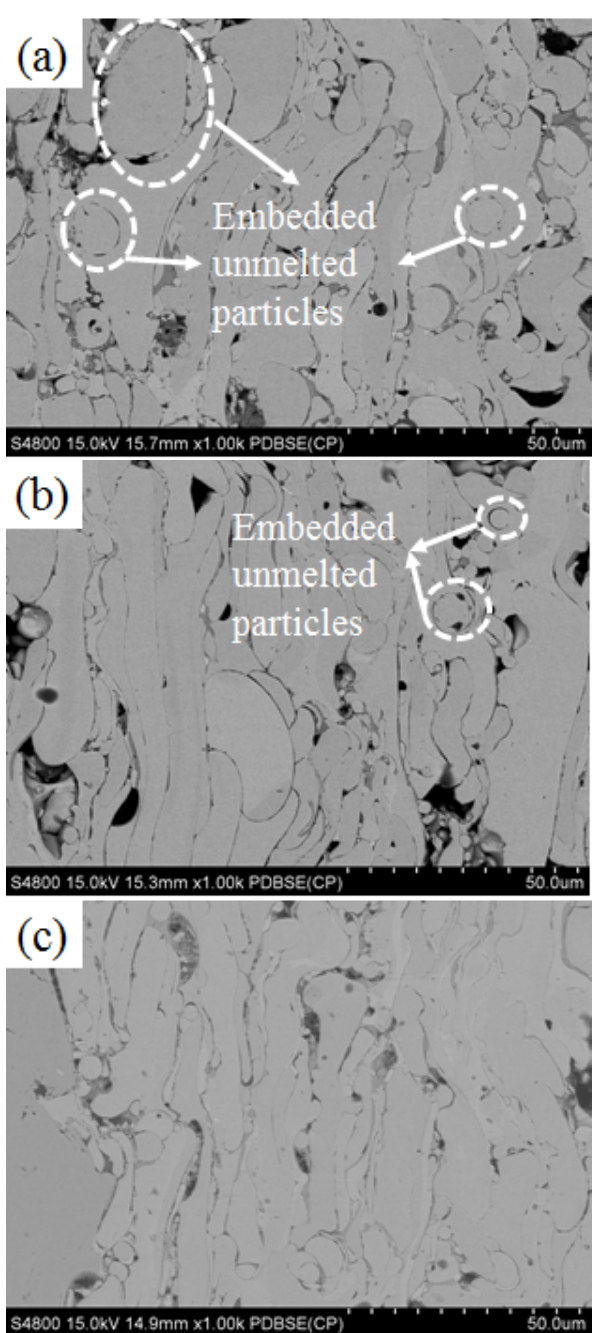
Figure 2: SEM images of the cross section of the amorphous coat- ings deposited under different spraying power levels (a) 30kW, (b) 35kW and (c) 40kW, respectively.